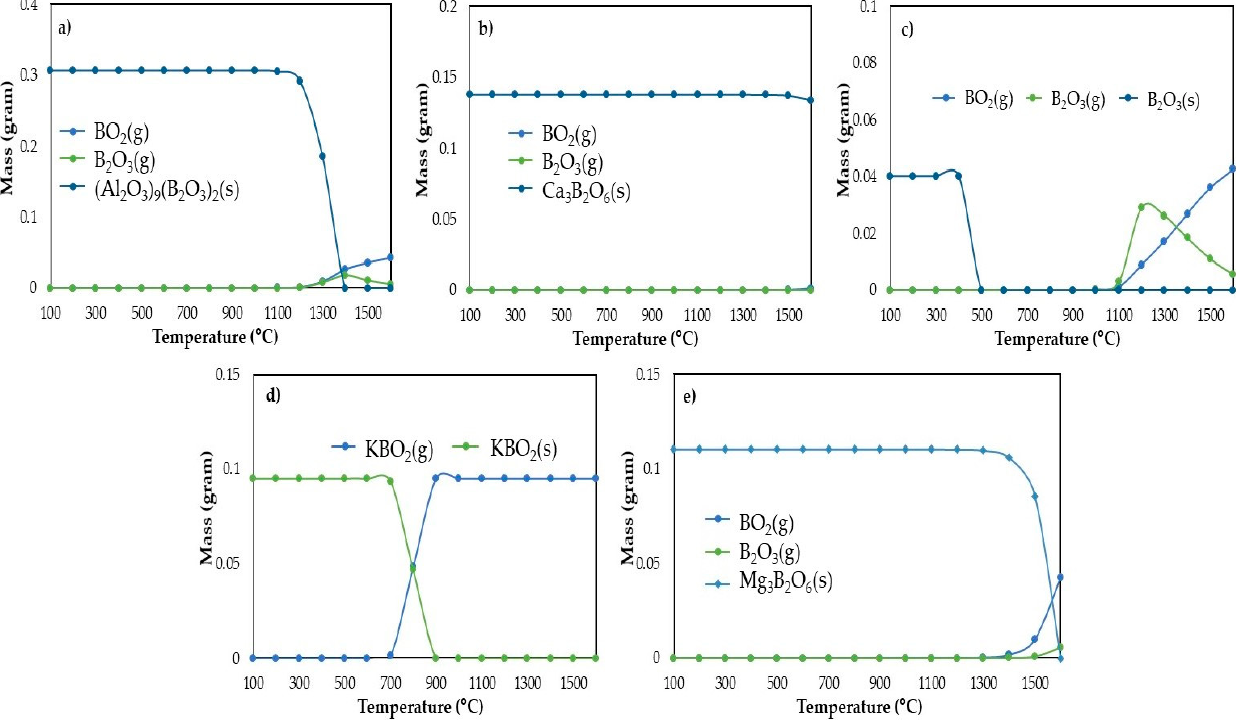
Figure 2. Equilibrium composition of B-Mineral oxides interactions during combustion: ( a ) B-O 2 -Al 2 O 3 ; ( b ) B-O 2 -CaO; ( c ) B-O 2 -Fe 2 O 3 ; ( d ) B-O 2 -K 2 O, and ( e ) B-O 2 -MgO.